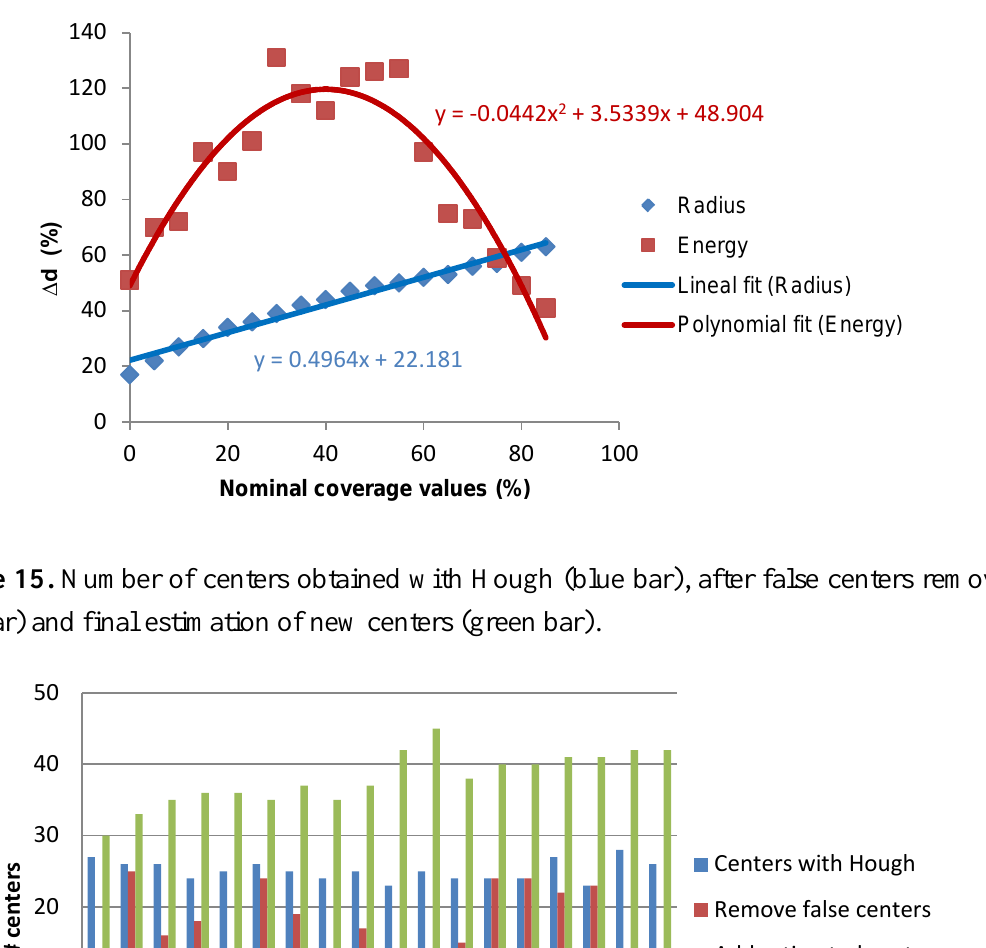
y = -0.0442x 2 + 3.5339x +